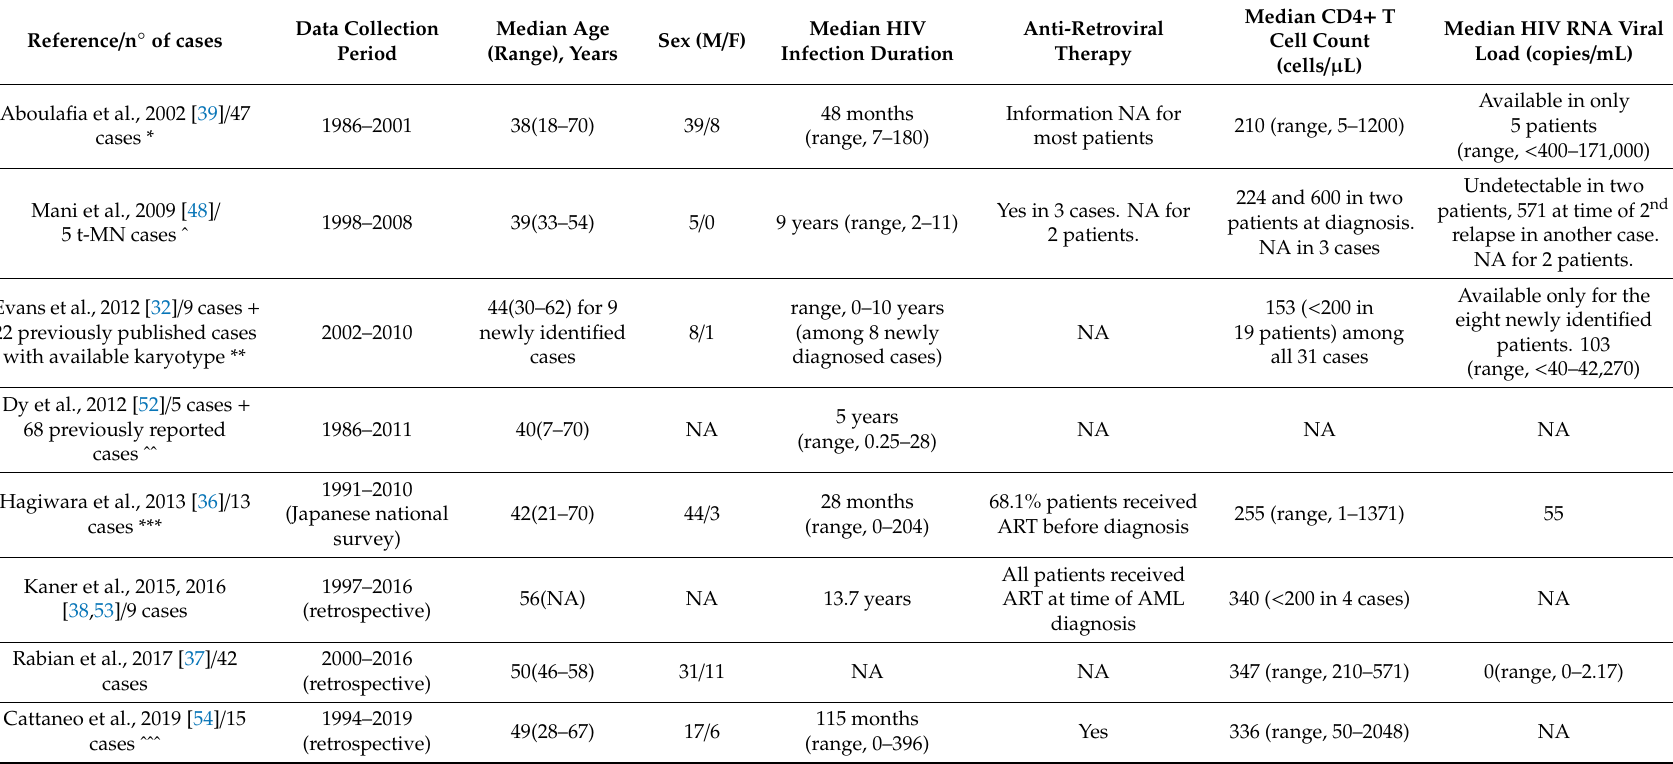
Table 1. Acute myeloid leukemia (AML) and HIV infection: demographics and patients’ characteristics at